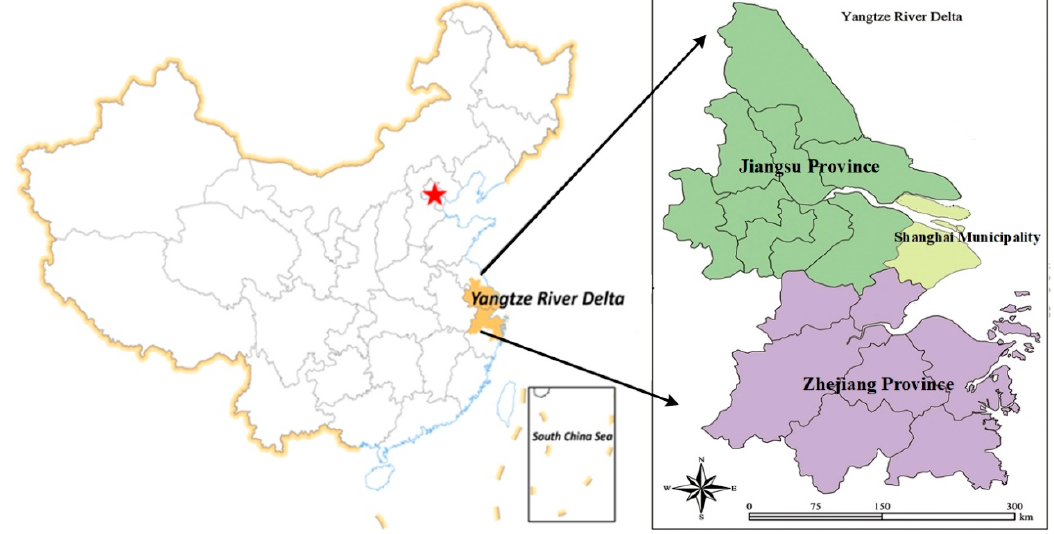
Figure 2. Location and administrative divisions in the YRD